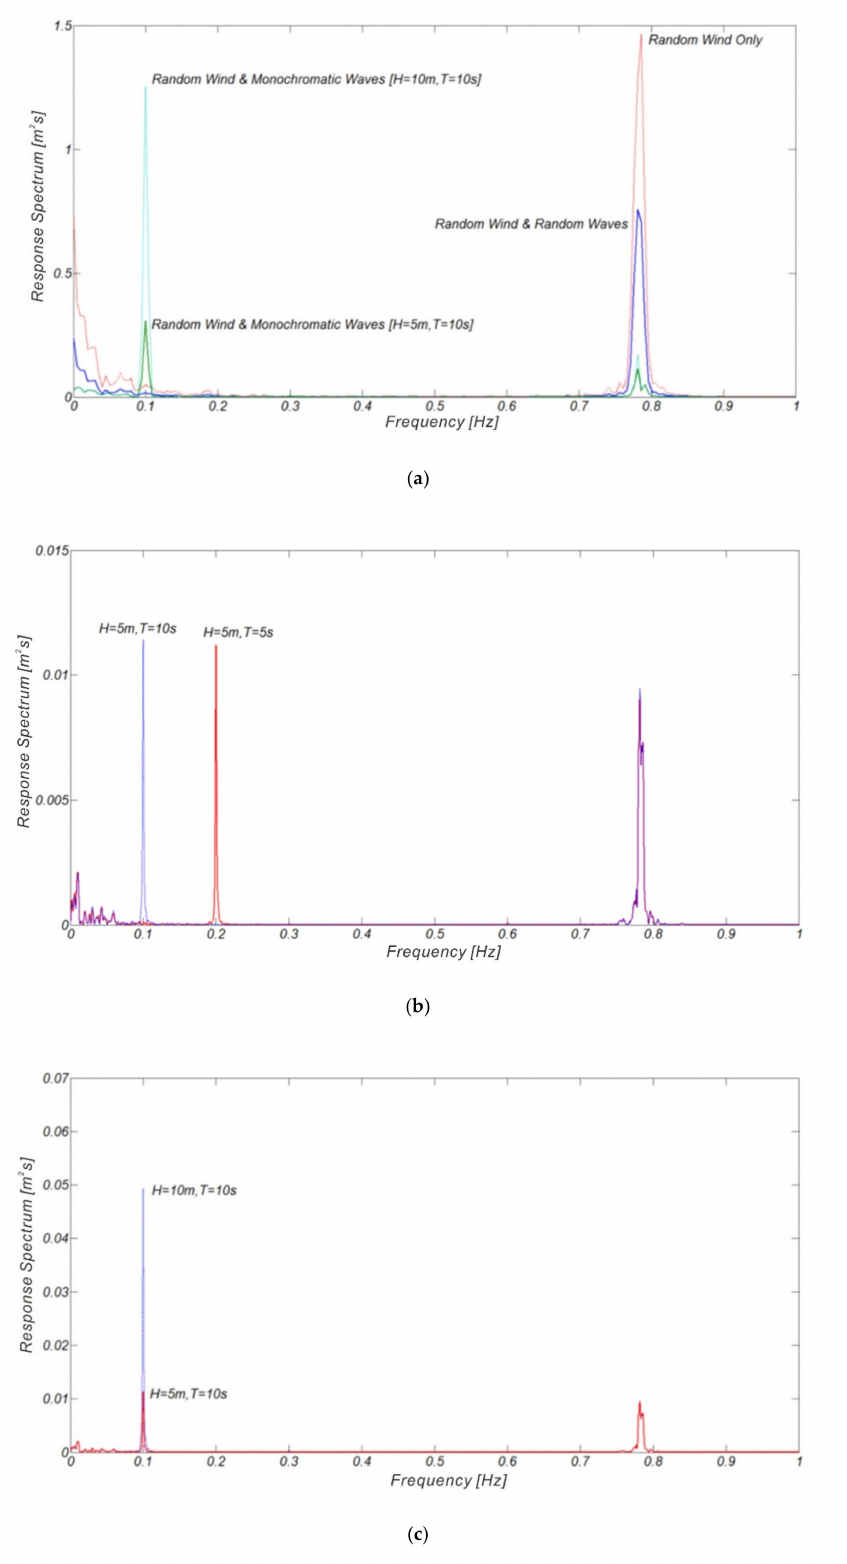
Figure 19. Response spectrum of the o ff shore wind turbine substructure against di ff erent combinations of external forces ( a ) comparison of response spectrum against varying environmental loads and ( b ) against turbulent wind and monochromatic waves with varying wave period, and ( c ) against turbulent wind and monochromatic waves with varying wave